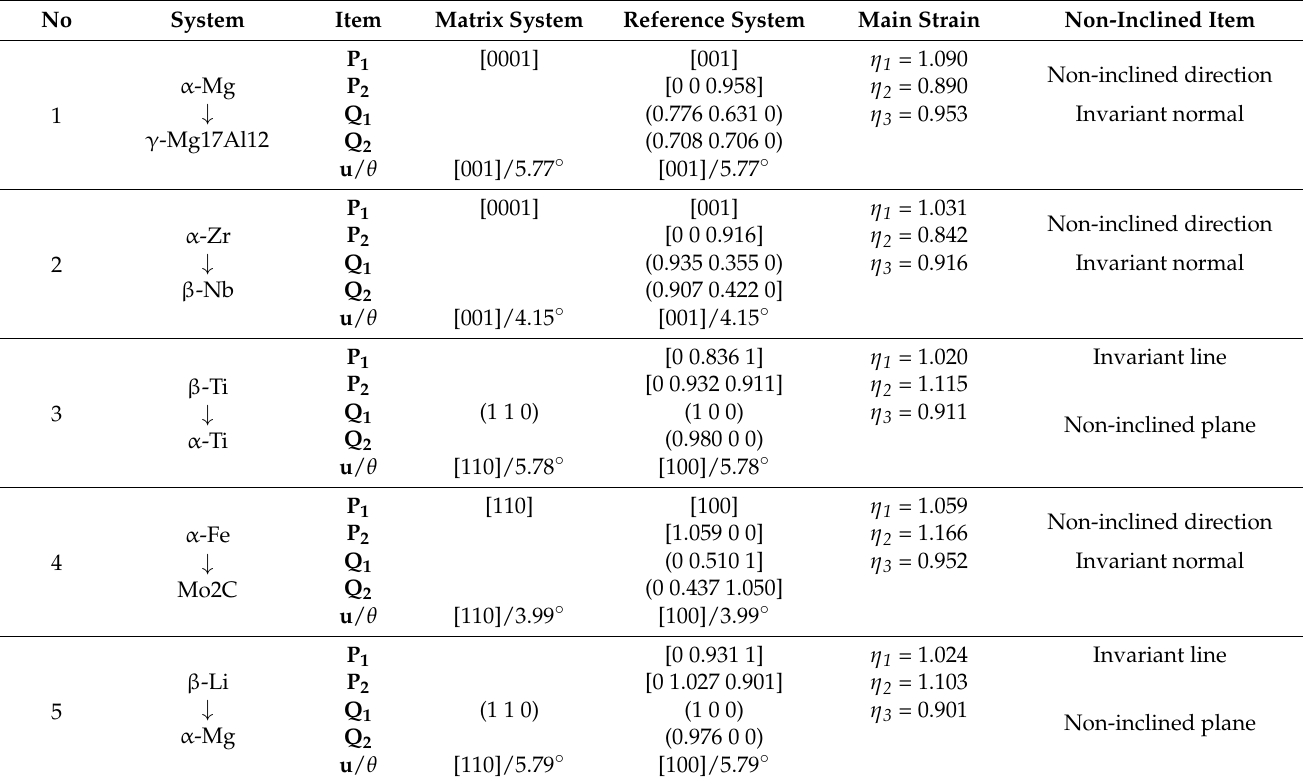
Table 2. Calculation details and intermediate results of crystallographic features of the five investi- gated